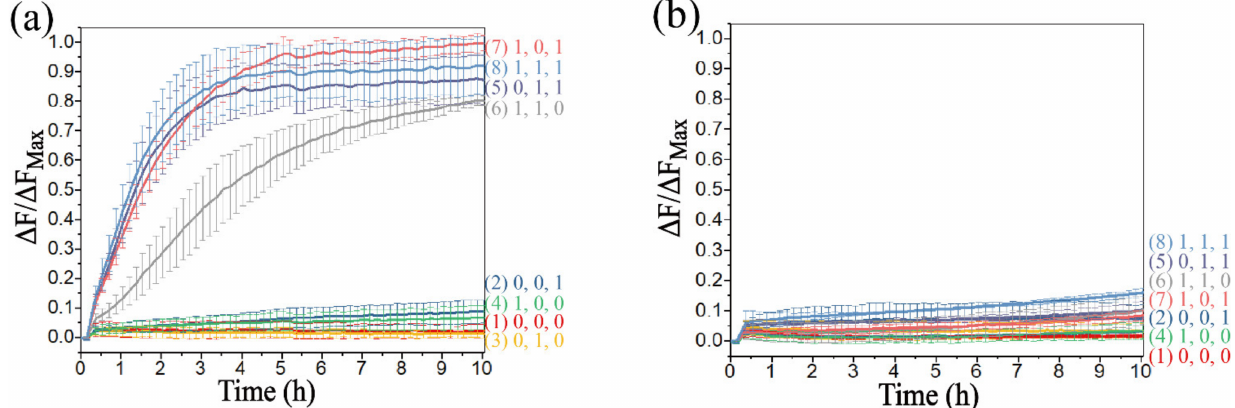
Figure 9. Time-dependent normalized fluorescence curves without ( a ) and with ( b ) the addition of IN 4 . The fluorescence intensities are recorded every 10 min. (1) No input is added; (2) D1 R is added; (3) D-IN is added; (4) D2 R is added; (5) D1 R and D-IN are added; (6) D2 R and D-IN are added; (7) D1 R and D2 R are added; (8) D1 R , D-IN and D2 R are